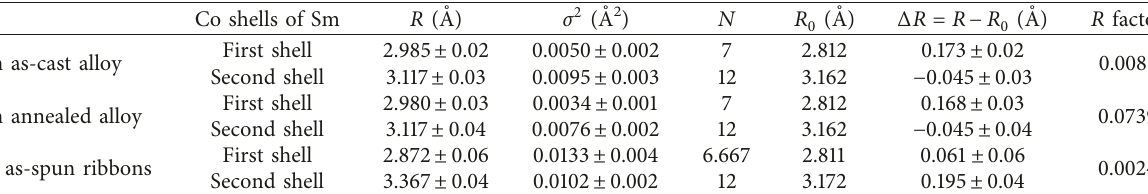
Table 2: The fitting results for 2:17R and 1:7H phases in SmCo Sm and Co in standard 2:17R and 1:7H unit cells represents the distance between Sm and its first and second Co shells in standard 2:17R and 1:7H structures. R factor is the sum-of-squares measure of the fractional misfit. The errors of R , σ 2 , and R 0 are shown behind the “